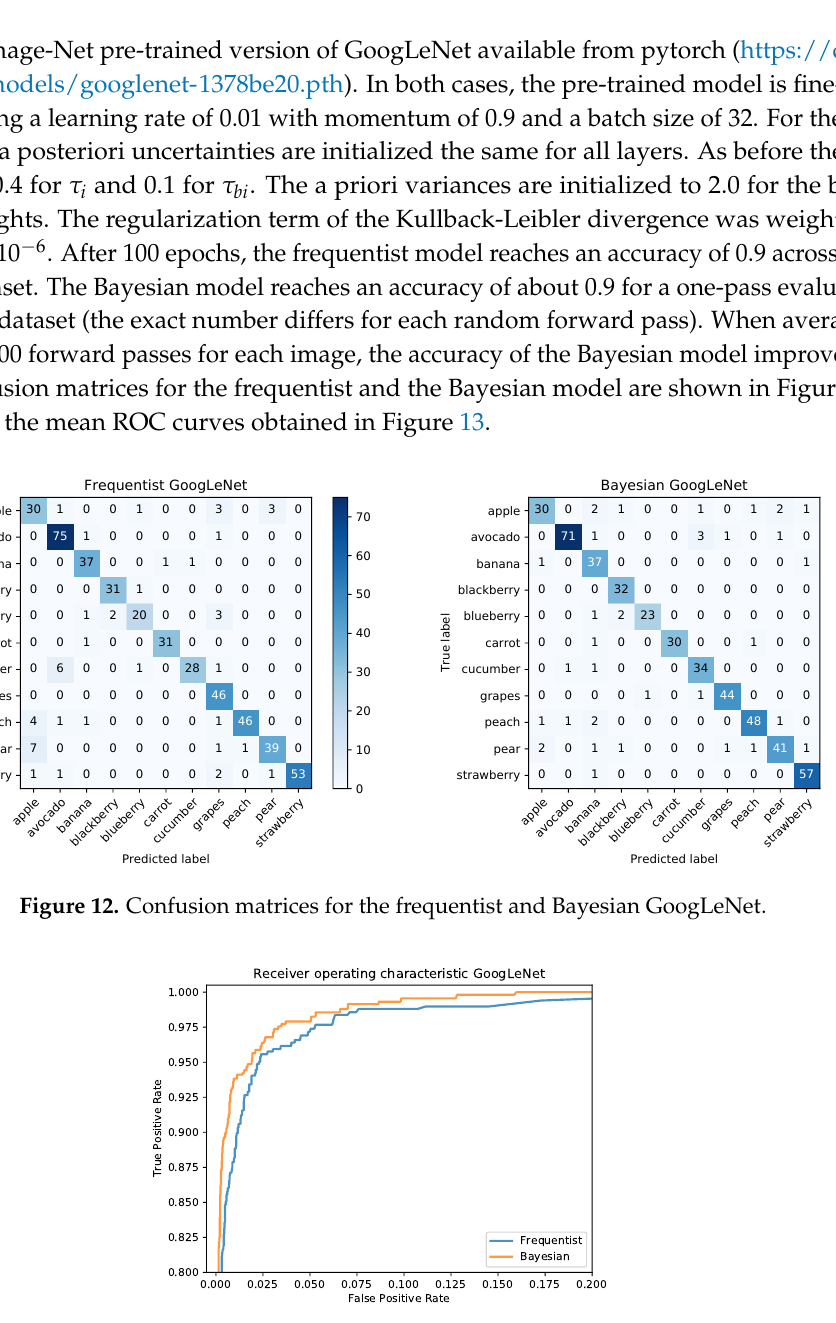
Figure 13. Mean ROC curves for the frequentist and the Bayesian model.